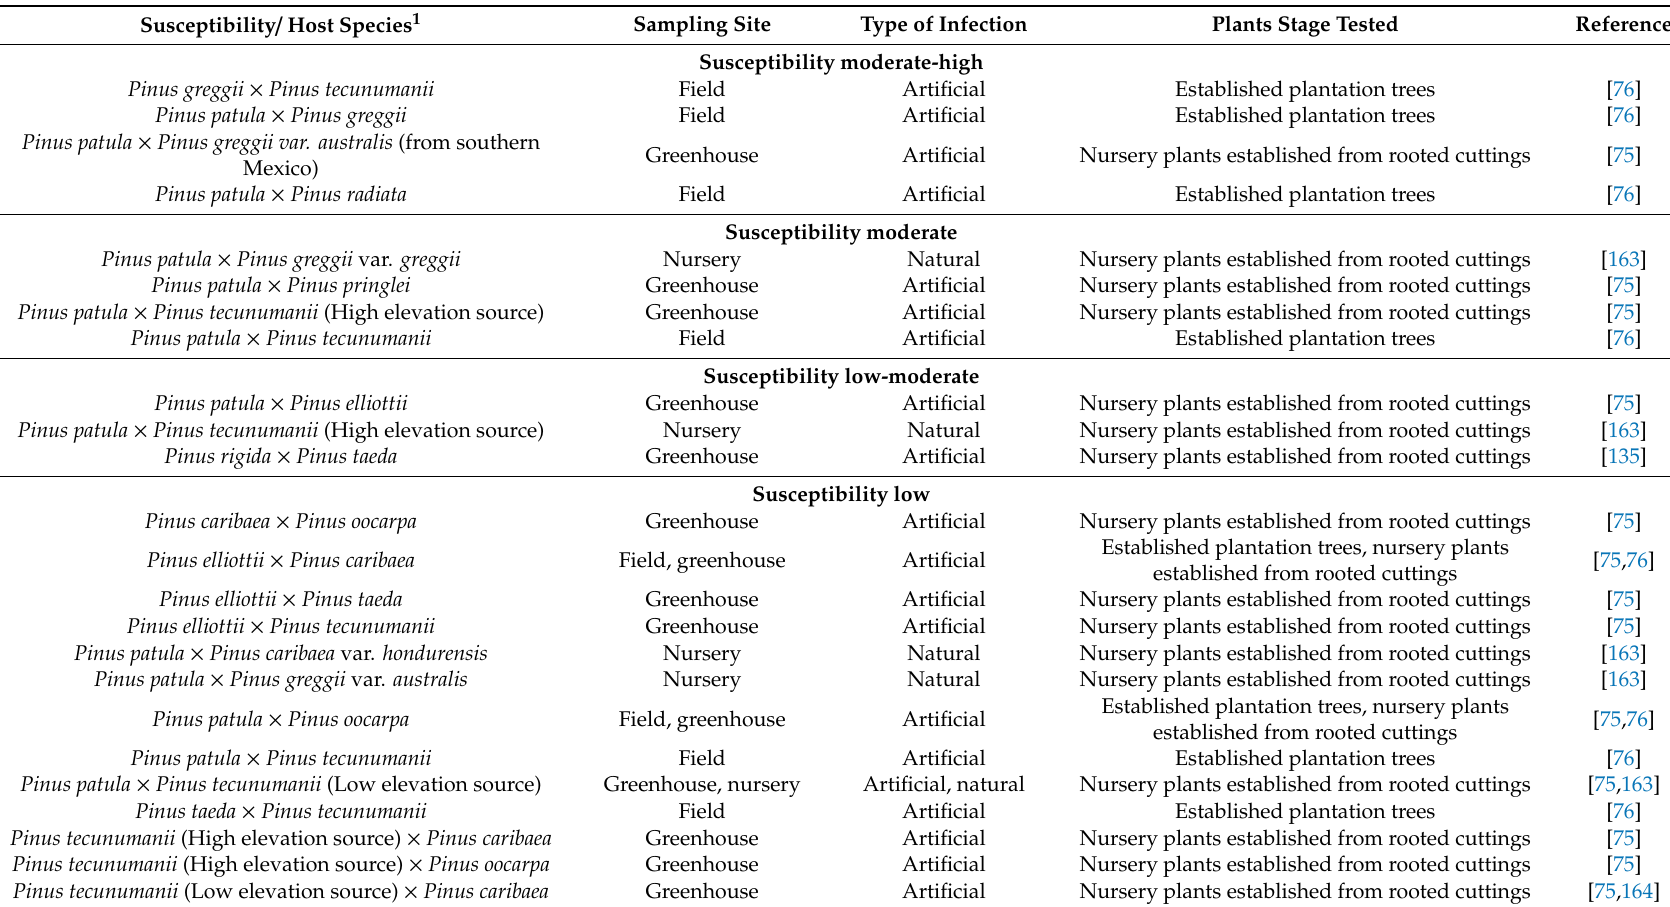
Table 5. Susceptibility list of Pinus hybrids to Fusarium